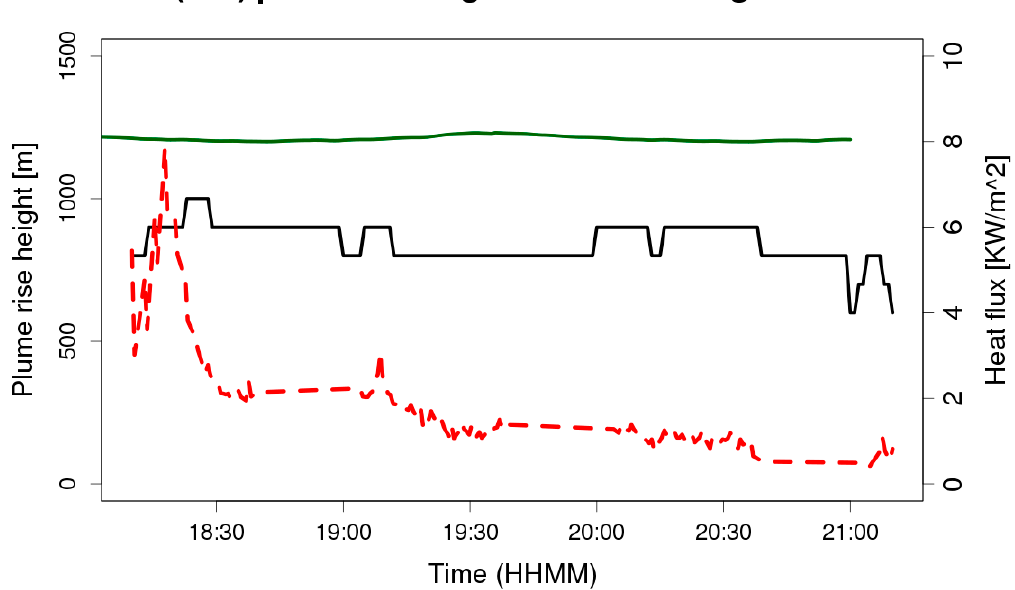
Figure 9. Time series of model-estimated plume rise heights (solid-black line), model-estimated planetary boundary layer (PBL) heights (solid-green line), and fire heat fluxes (red-dashed line) during the L2F prescribed burn.